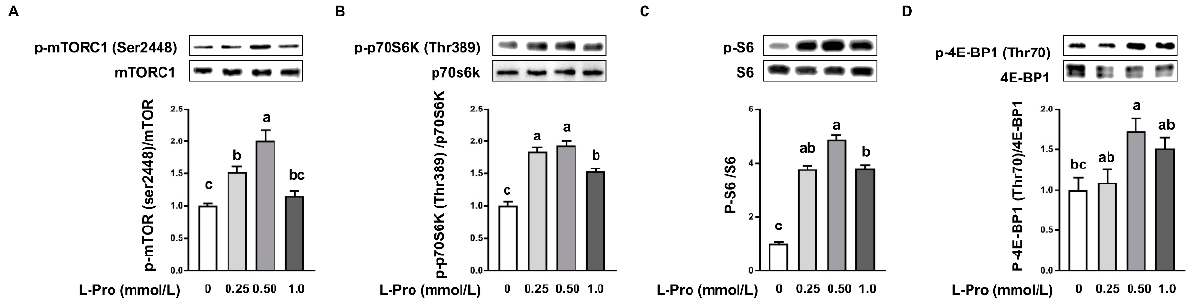
Figure 2. Effects of proline on mTORC1 signaling pathway in pTr2 cells. ( A ) The protein abundance of total and p-mTORC1 in pTr2 cells. ( B ) The protein abundance of total and p-p70S6K in pTr2 cells. ( C ) The protein abundance of total and p-S6 in pTr2 cells. ( D ) The protein abundance of total and p-4E-BP1 in pTr2 cells. Data are expressed as the percentage of control group. Values are means ± SEMs, n = 3. Means at a time point without a common letter differ, p < 0.05. 4E-BP1, eukaryotic translation initiation factor 4E-binding protein 1; mTORC1, mammalian target of rapamycin complex 1; p, phosphorylated; p70S6K, ribosomal protein S6 kinase; pTr2, porcine trophectoderm cell line 2.